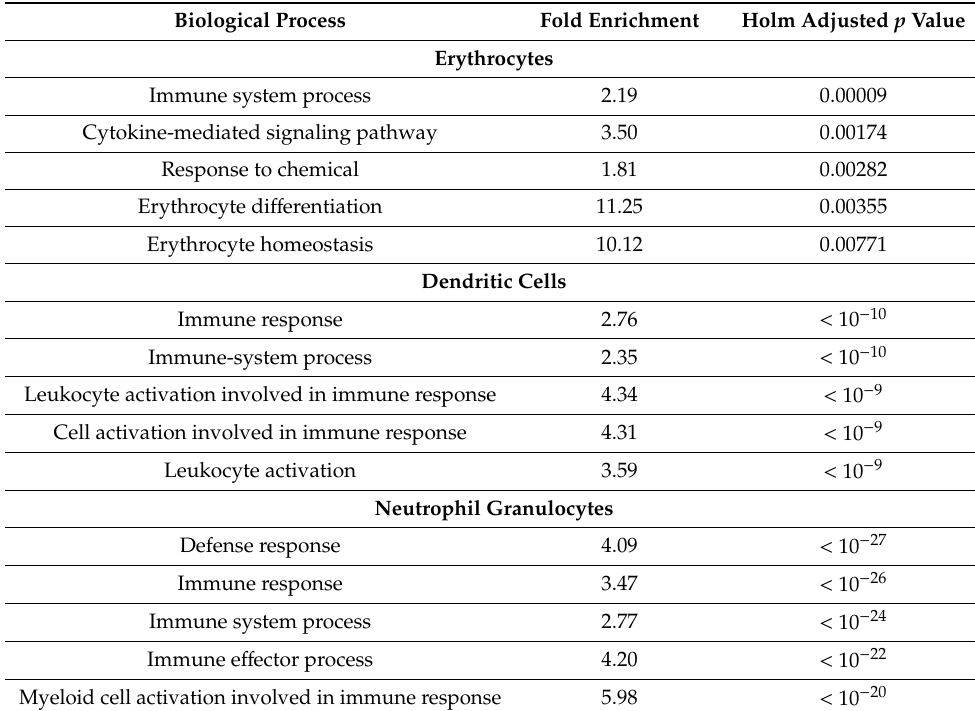
Table 1. Gene ontology enrichment analysis, using the Fisher’s exact test type in combination with Holm adjusted p value, from the di ff erentiated lineages. The five most significantly enriched biological processes in each lineage are